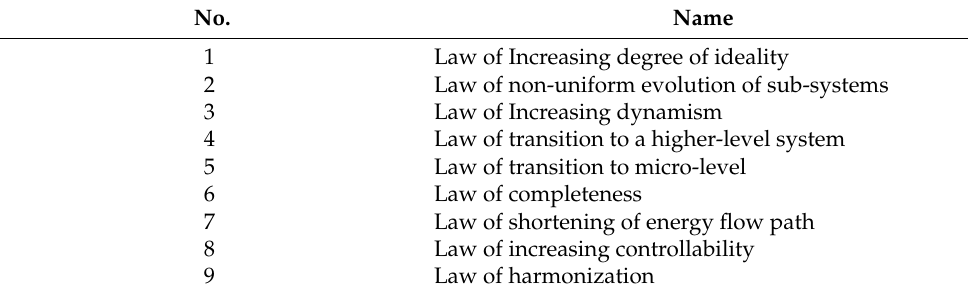
Table A2. The nine technological evolution laws.